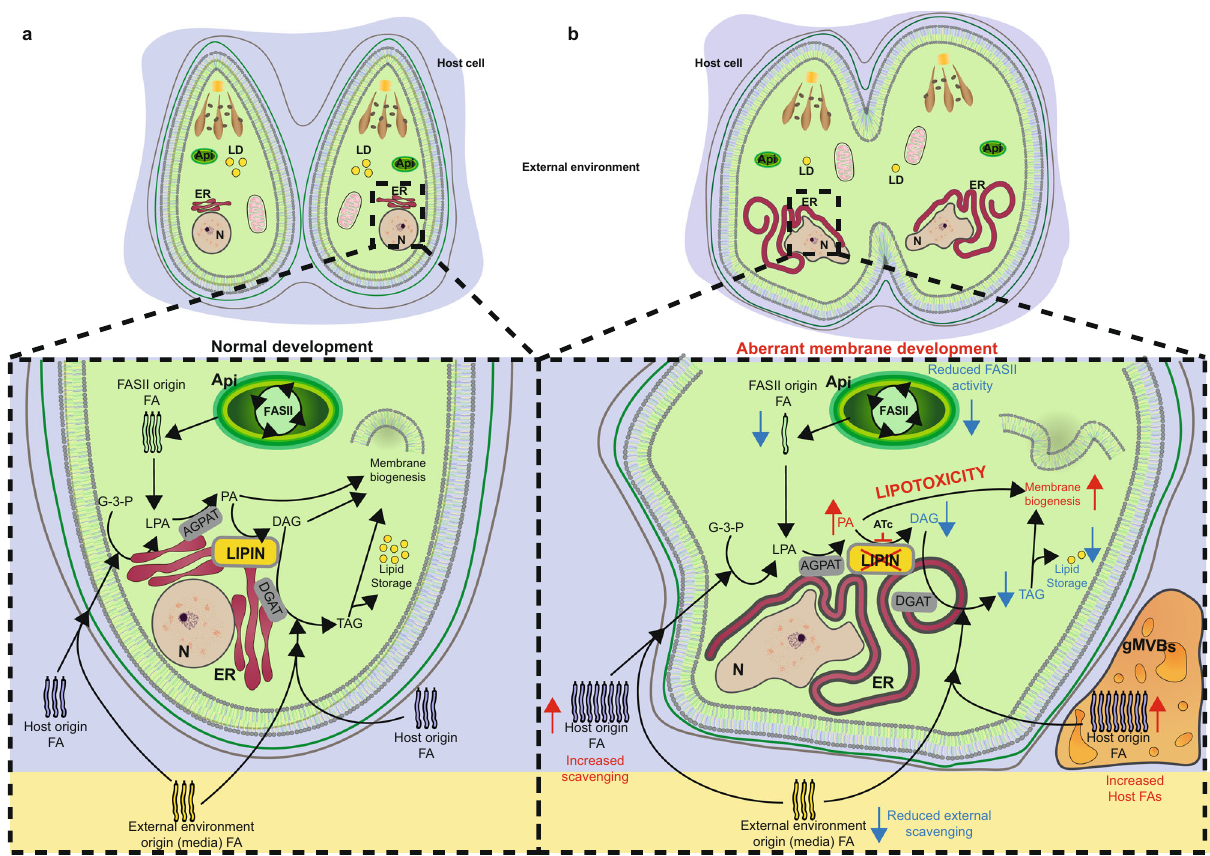
Fig. 6 Proposed role of LIPIN in Toxoplasma lipid metabolism. Schematic representation of the dual essential role of Tg LIPIN in parasite lipid metabolism, including, membrane biogenesis, and lipid storage. a The parasite utilizes, and glycerol-3-phosphate (G-3-P) and fatty acid (FA)s derived from both apicoplast (Api) FASII and host to synthesize major lipids by forming lysophosphatidic acid (LPA) followed by phosphatidic acid (PA). PA is hydrolyzed by Tg LIPIN to generate diacylglycerol (DAG), which is further acylated to generate triacylglycerol (TAG). The other branch of this pathway redirects PA toward the generation of major membrane phospholipids. The FA homeostasis between membrane biogenesis and storage essential for normal parasite development within its host is maintained by the PA phosphatase Tg LIPIN. b Genetic ablation of Tg LIPIN in Tg LIPIN-ikD parasites in the presence of anhydrotetracycline (ATc) caused the PA/DAG imbalance. The increased PA is channeled towards PL synthesis resulting in excess PLS and consequent gross membrane anomalies within the parasite IMC, nucleus, and ER, while forming giant multivesicular bodies (gMVBs). Simultaneously, the reduction in DAG affected TAG biogenesis and hence the lipid storage capacity, marked by decreased lipid droplets (LD), within the parasite lacking Tg LIPIN. The impairment of TAG biosynthesis, resulted in excess fatty acids derived from the host, within Tg LIPIN mutant, causing